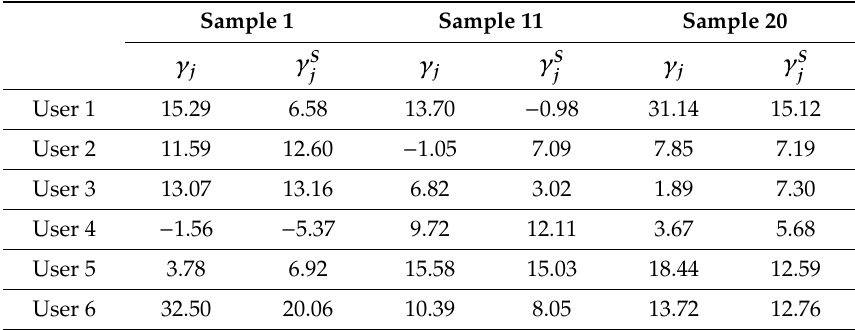
Table 2. Channel qualities of the basic multicast channel (BMCH) and the supplementary multicast channel (SMCH) for six users at three sample points (in